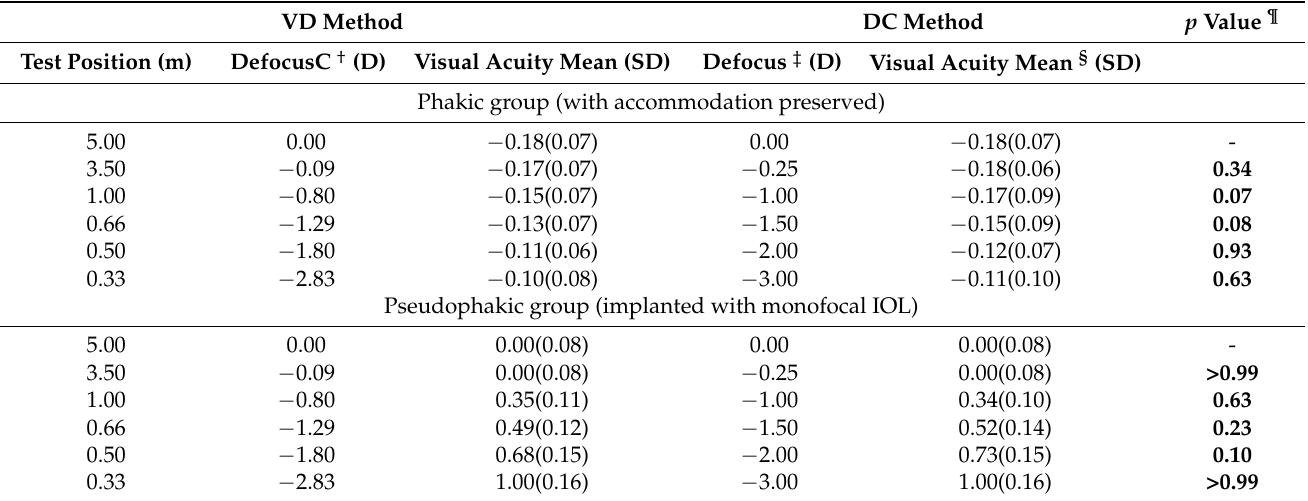
measurements were taken with the best distance correction. p values > 0.05 appear